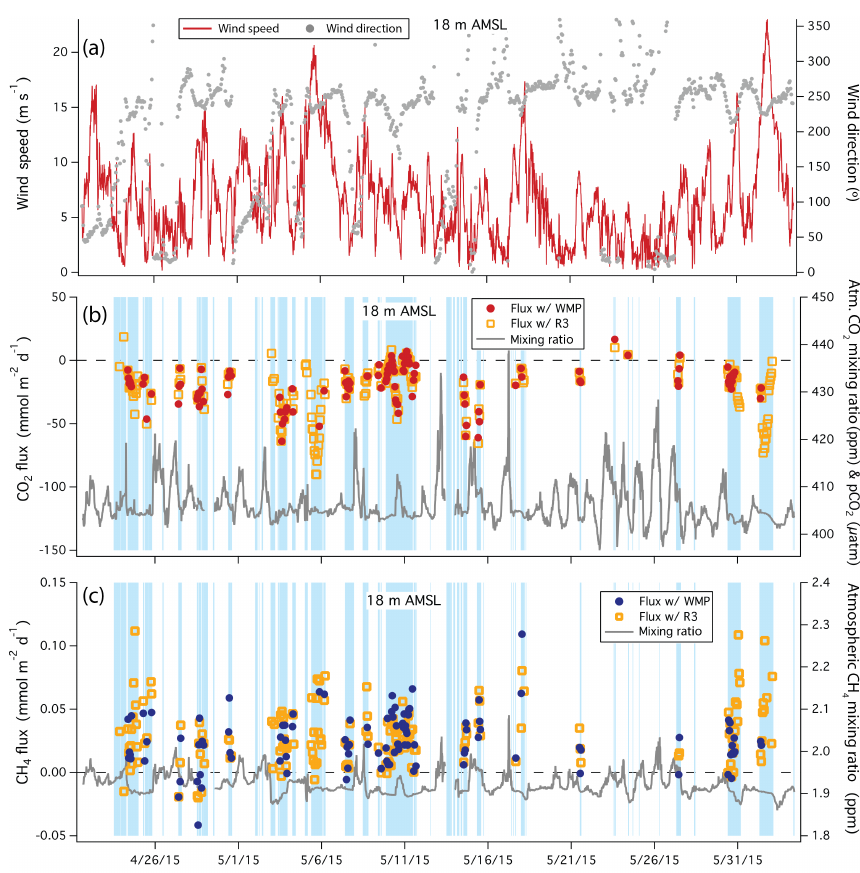
Figure 11. As Fig. 10, but during April–June 2015 (sampling height of 18ma.m.s.l.). Fluxes were computed from both the Windmaster Pro and the R3 sonic anemometers. Large air-to-sea flux of CO 2 is observed during high wind speed events, while CH 4 flux is almost always